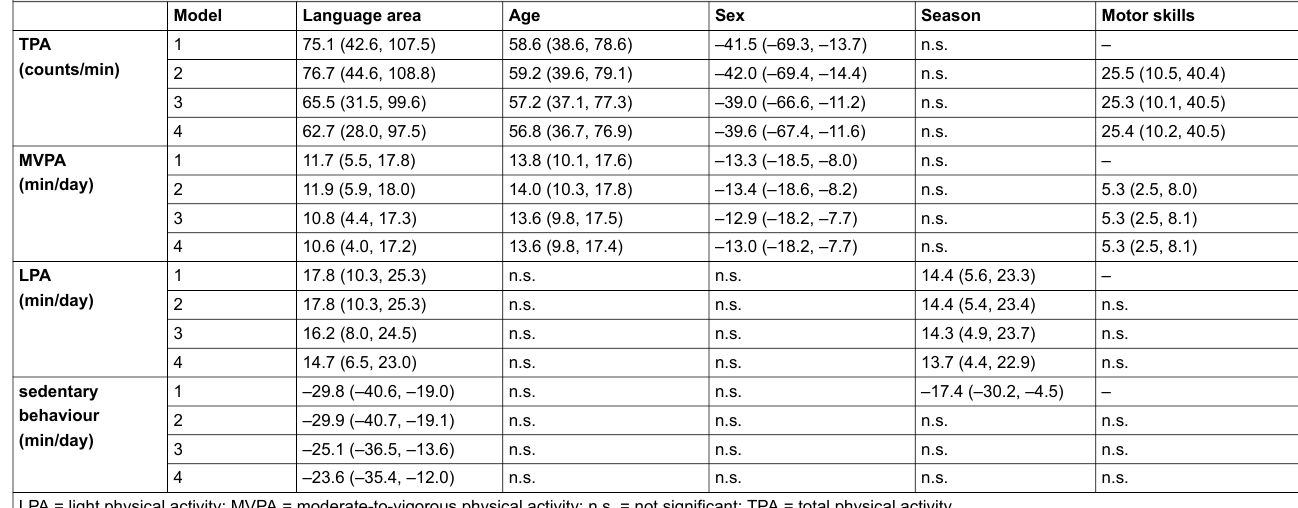
Table 2: Data show imputed beta coefficients with 95% confidence limits for significant tested correlates of physical activity according to four models based on the socioecological theory.